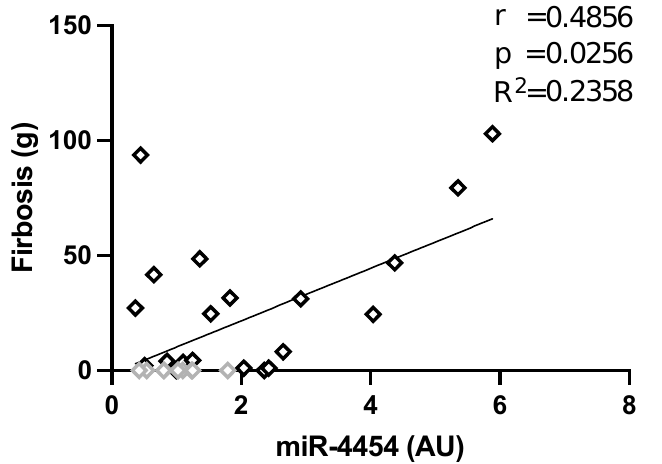
Figure 2. Correlations of LV fibrosis to miRNA-4454 expression in HCM patients. Pearson correlation and linear regression analysis were carried out and a significant correlation of LV fibrosis with the relative expression of miRNA-4454 was determined in HCM patients. For comparison, the controls are given in grey.